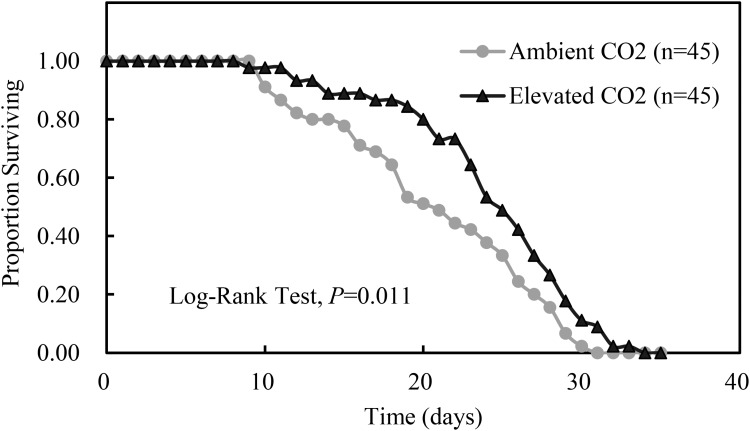
Kaplan–Meier survival curves of Aphis gossypii fed on the cotton plant under different CO2 levels (ambient vs. elevated) (The significant difference between the treatments of ambient and elevated CO2 were obtained by log-rank test at P < 0.05).